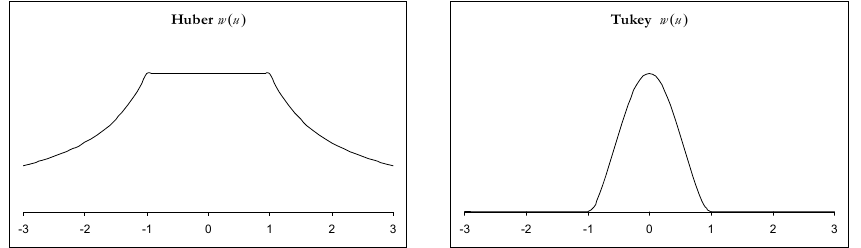
Figure 5 – Huber’s and Tukey’s weight functions for k